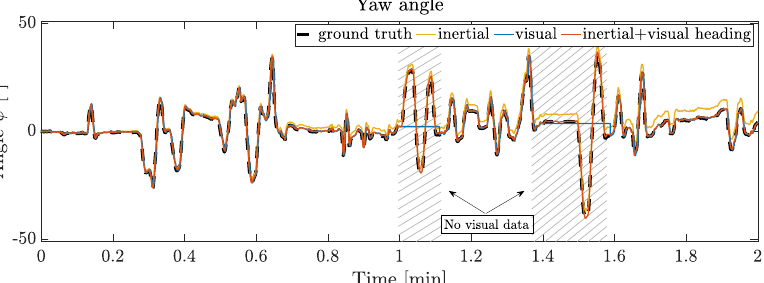
Figure 10. Sequence of yaw angle estimations during complete loss of visual data. Yaw Angle estimations: ground truth (black), the proposed orientation estimation (orange), the inertial only orientation estimation (yellow) and the visual orientation estimation only (blue). During complete loss of visual feedback (hatched areas) the filter switches the input heading source to the IMU heading vector to calculate reliable data until visual data is available